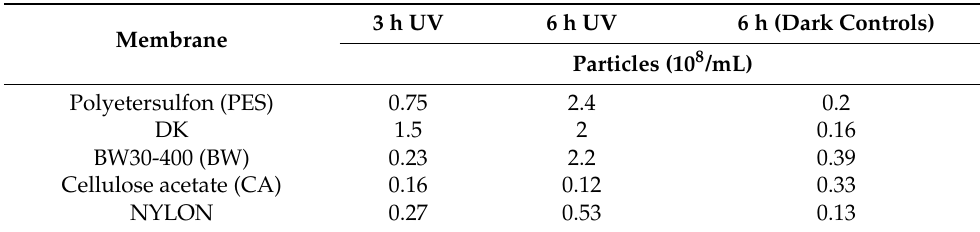
Table 8. Amount of nanoparticles present in aqueous media for polymeric membranes not exposed and exposed to UV illumination [101].